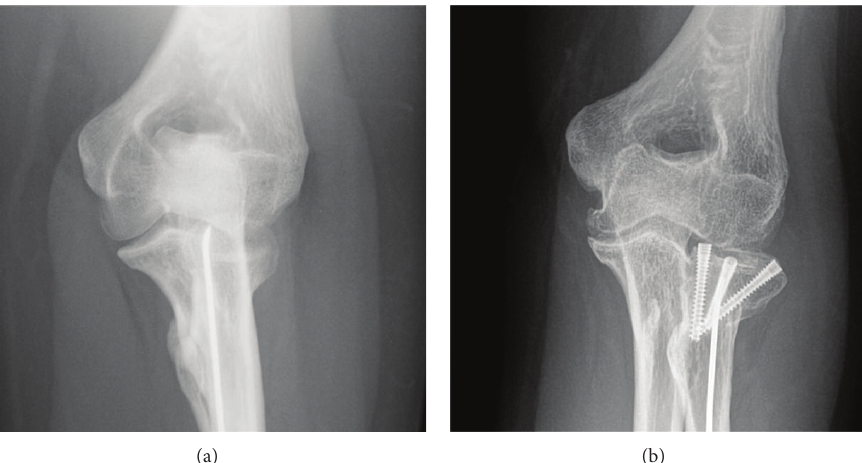
Figure 1: (a) Preoperative anteroposterior X-ray showing the radial neck malunion. (b) Postoperative anteroposterior X-ray showing the radial head fixation.